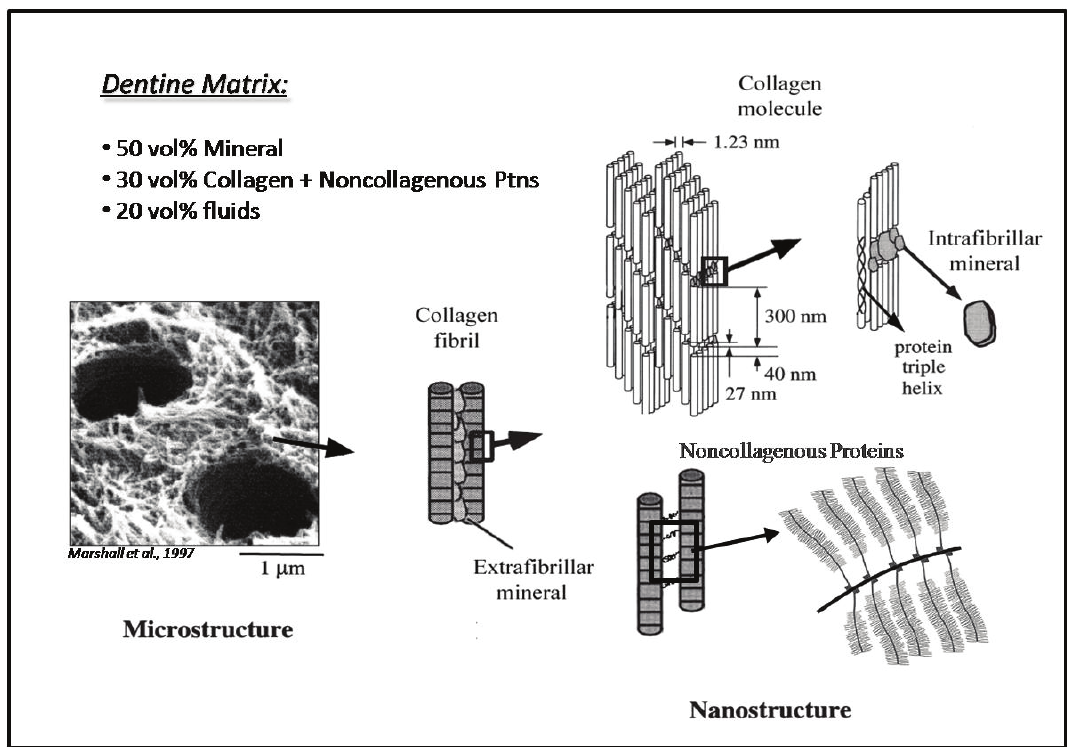
Figure 2. From left to right: SEM image of a fixed, demineralized dentin matrix showing the collagen fibrils. In the schematic on the left, collagen fibrils show the extrafibrillar mineral between fibrils. In the next schematic to the right, the collagen molecules show the 40 nm gap zones and 27 nm overlap zones resulting in the typical 67 nm periodicity of a collagen fibril. The length of the collagen protein triple helix is 300 nm. On the upper right, the intrafibrillar mineral is represented sitting in the gap region between the collagen molecules. The lower middle schematic shows noncollagenous proteins linking collagen fibrils and isolated on the far right. Figure not drawn to scale. Modified from Bertassoni et al.